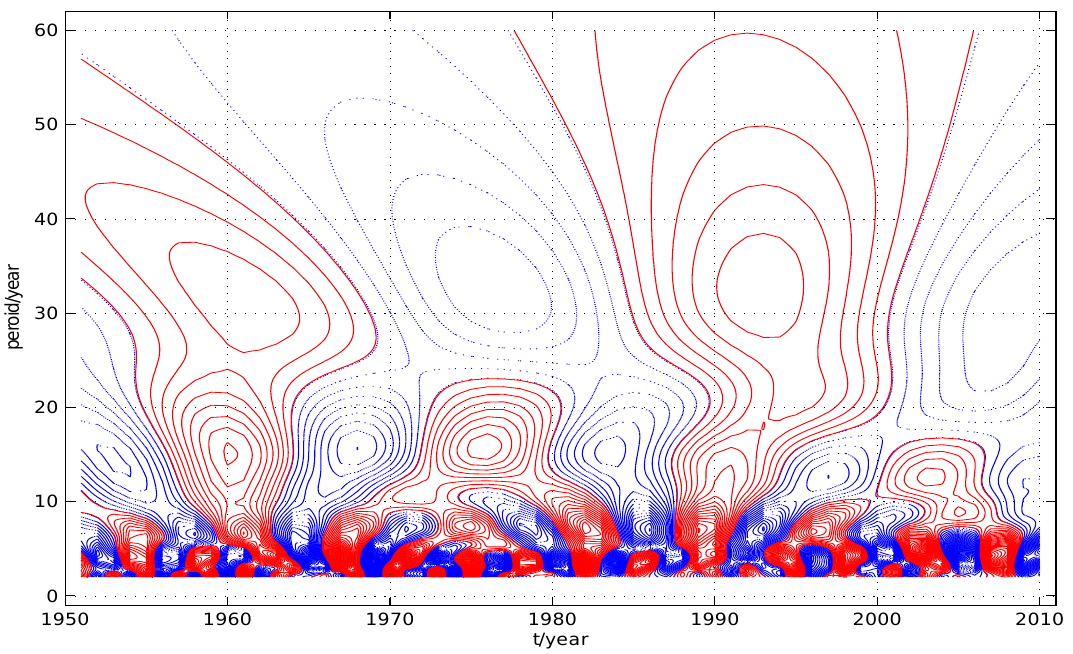
Figure 7. This contour, computed with the case 0 of Algorithm 3 with M = N + 2 aT , manifests no edge effect. Table 2. The wavelet entropy corresponding to different wavelet transform methods. σ 2 CWT Zhao’s Method Algorithm 2 Algorithm